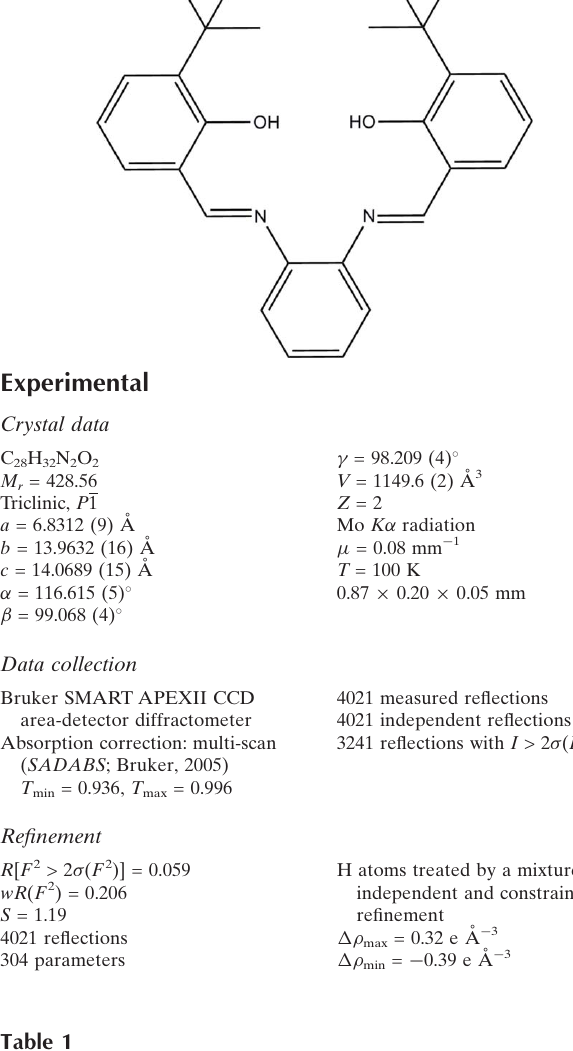
Hydrogen-bond geometry (A˚ , (cid:2)